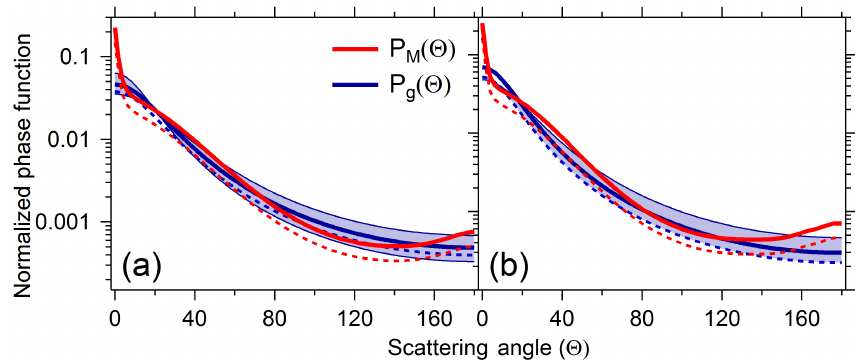
Figure 10. Comparison of area-normalized phase functions under (a) low AOD (22 July 2012 at 8:50LST) and (b) high AOD (17 July 2012 at 15:50LST). Solid and dashed lines represent the normalization between 5 and 180 and 0 and 180 ◦ , respectively. The blue shaded represent a typical error in g of 10% (shown only for the solid